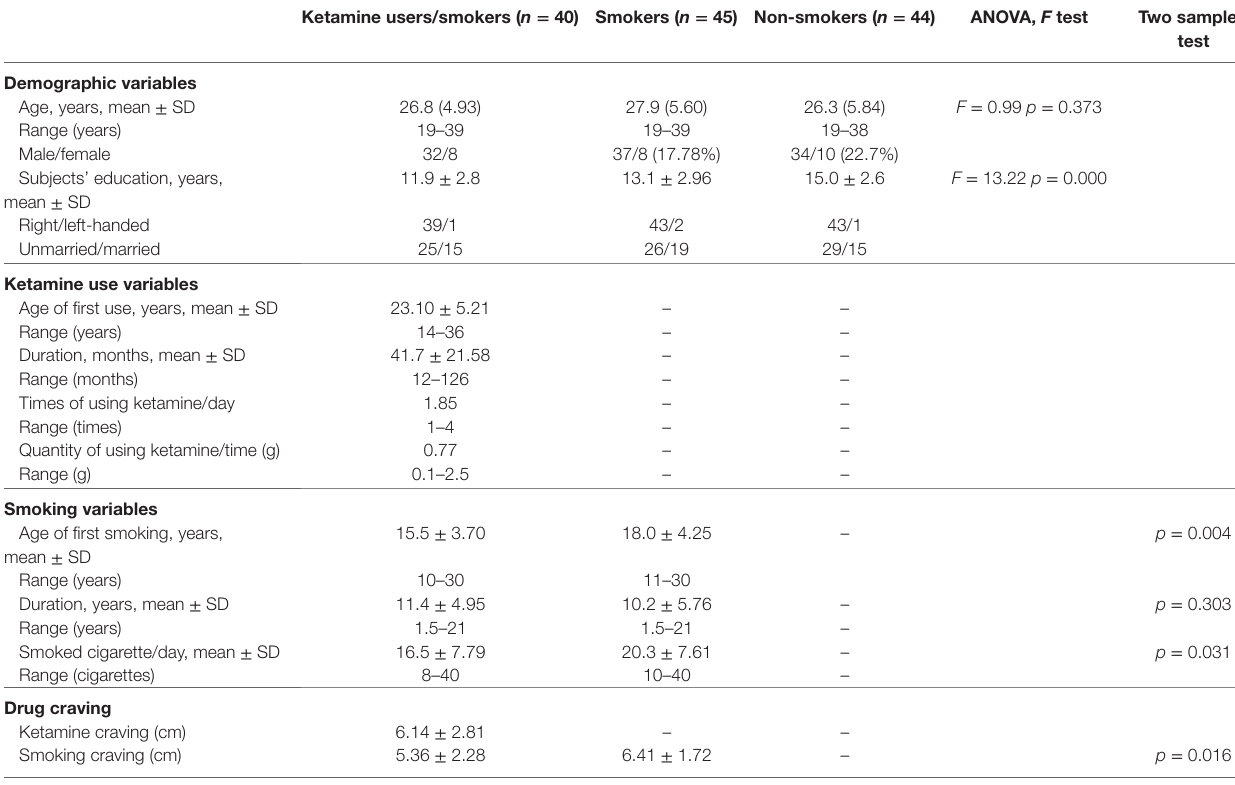
TaBle 1 | Demographic and drug use characteristics of patients with ketamine dependence, chronic smokers and HC